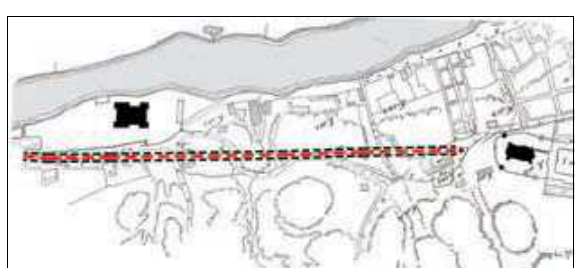
Fig. 5. the present direction of t. kosciuška street.